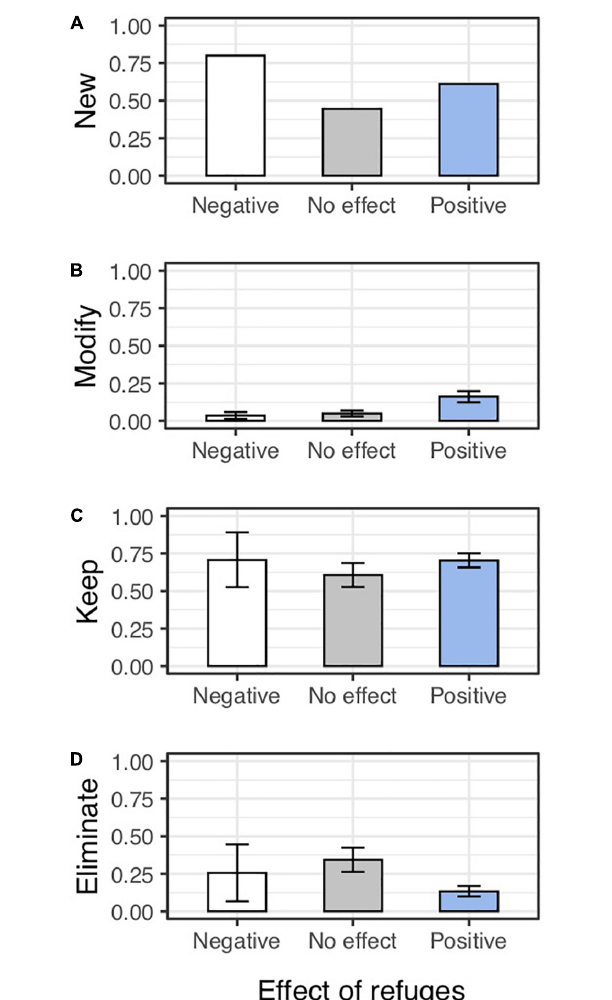
FIGURE 5 | Breakdown of respondents’ management proposals by whether they perceived positive ( N = 54, 63%), null ( N = 27, 31%), or negative ( N = 5, 6%) fishery results from the existence of fishing refugia. The y-axis represents the proportion of respondents from each group that proposed (A) a site for a new refugia, (B) the modification (in almost all cases, expansion) of existing refugia, (C) to keep their refugia as is, and (D) to eliminate refugia.